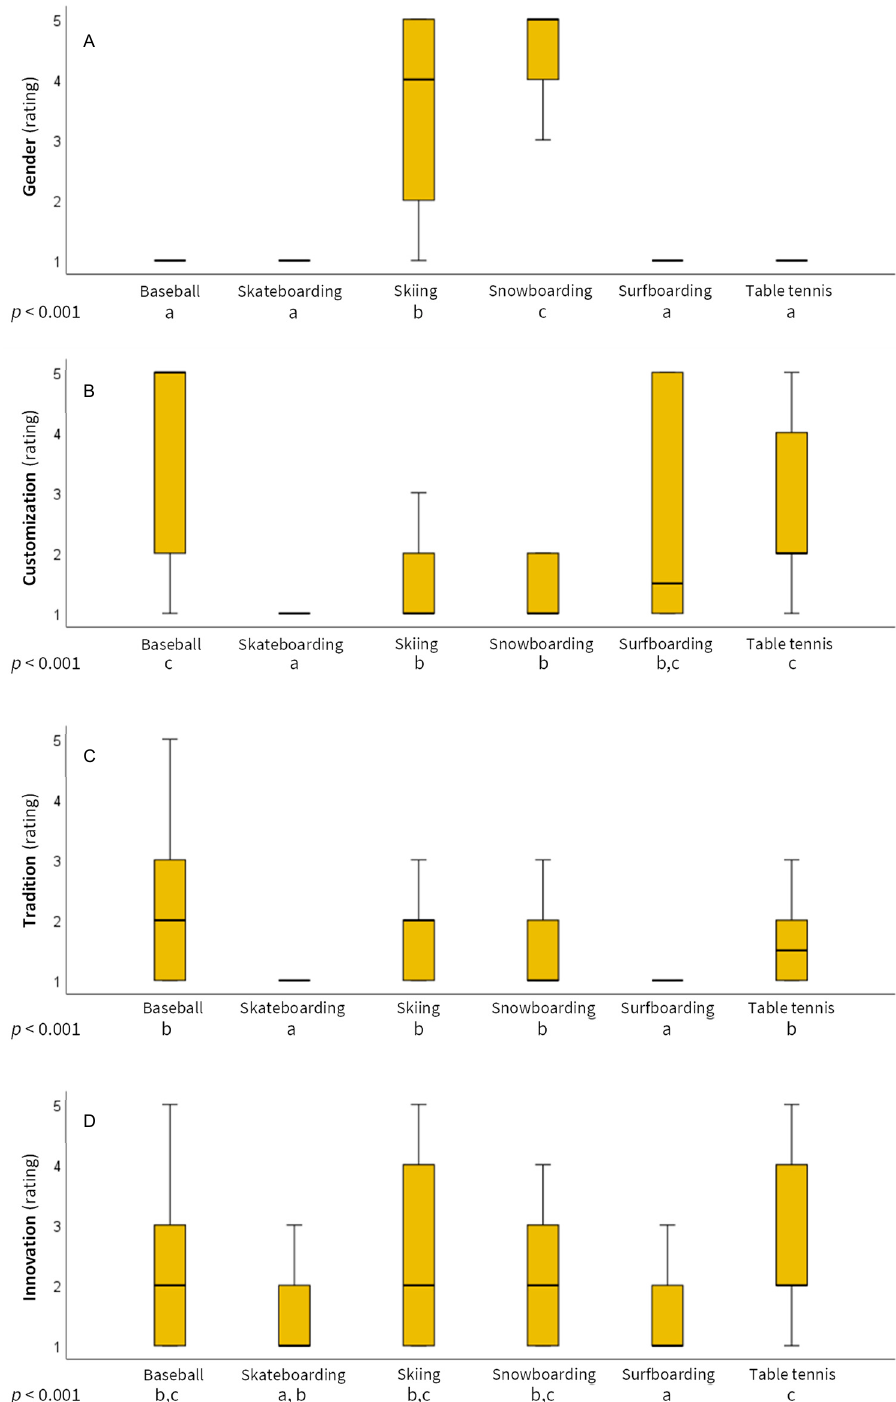
Figure 4. Results of the evaluation of the “Design” dimension, and grouping (a–c) based on statistical analysis. The subfigures show the results of the various Sub-Dimensions, namely Gender ( A ), Customization ( B ), Tradition ( C ), and Innovation ( D ).